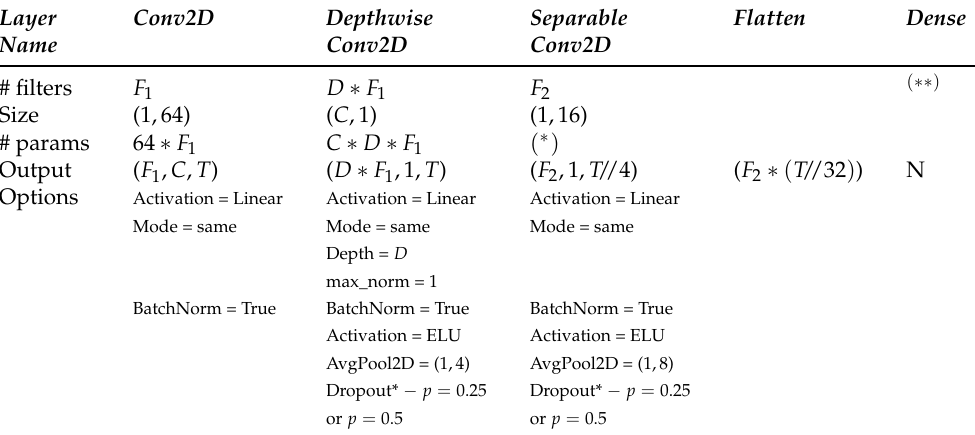
Table 1. EEGNet architecture. Input shape is (1, C , T ), where C is number of channels, T —number of time points, F 1 —number of temporal filters, D —depth multiplier (number of spatial filters), F 2 — number of point-wise filters, and N —number of classes, respectively. For the Dropout layer, we use p = 0.5 for within-subject classification. Notations ∗ stand for 16 ∗ D ∗ F 1 + F 2 ∗ ( D ∗ F 1 ) and ( ∗∗ ) for N ∗ ( F 2 ∗ T //32 )